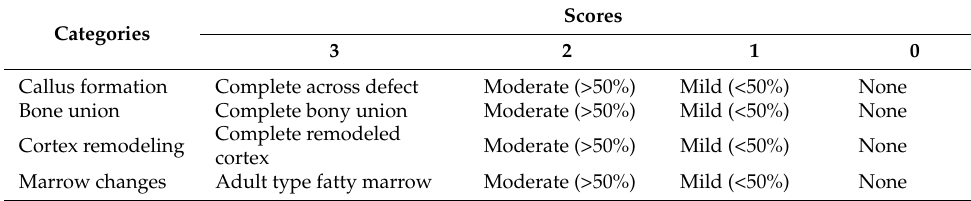
Table 2. Histological scoring system for fracture